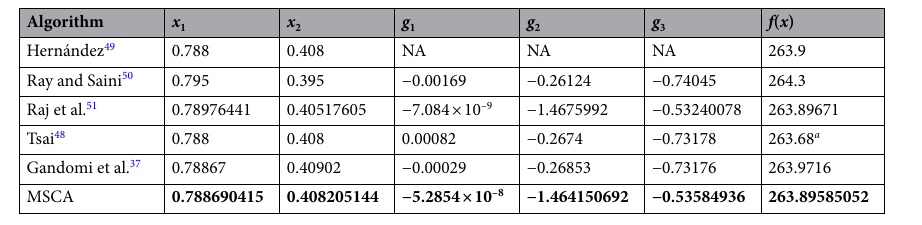
Table 10. The best solution for three-bar truss design problem. a means not infeasible; NA means not available. Significant values are in bold.